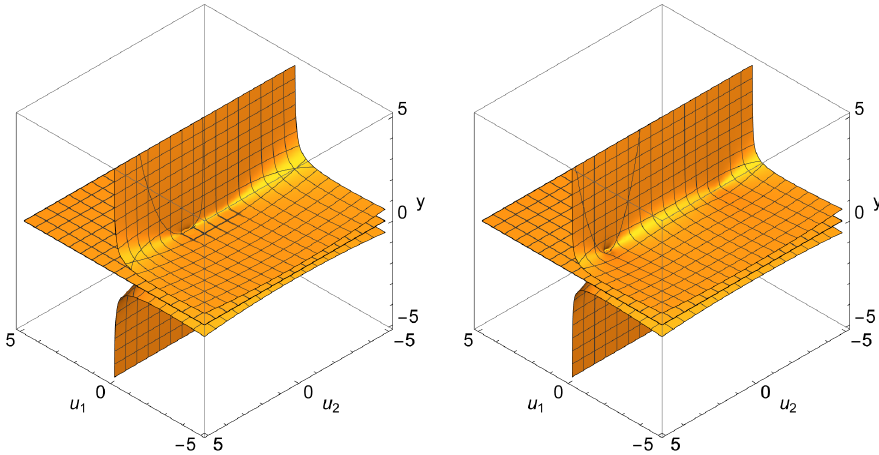
Figure 8. The two figures (from left to right) show the evolution of the space Σ asymptotic state ( in ) with the environment data asymptotic state ( out ) with frequency Ω +